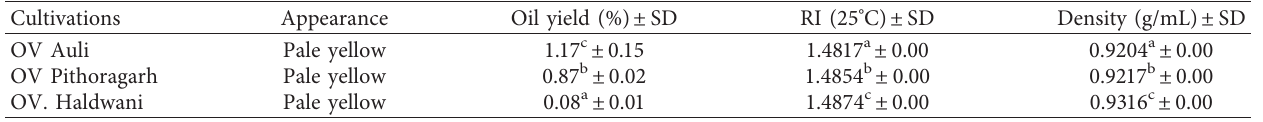
Table 3: Physical parameters and yield of the oils.